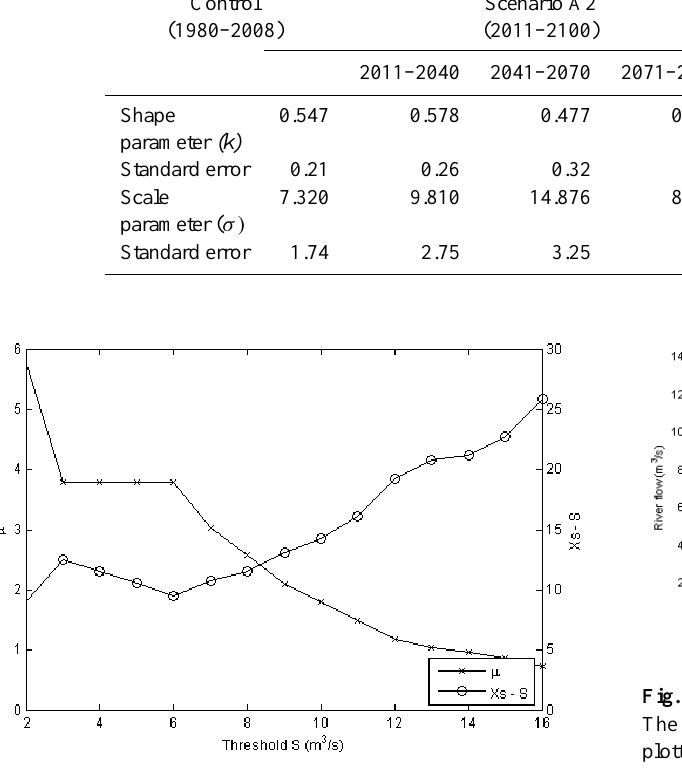
Figure 8 Threshold selection for the Anoia basin, using the Xs - S values to determine a 2 Fig. 8. Threshold selection for the Anoia basin, using the xs – s val- stable range of S, and selecting a threshold with µ > 2 peaks per year. 3 ues to determine a stable range of s , and selecting a threshold with µ >2 peaks per year.